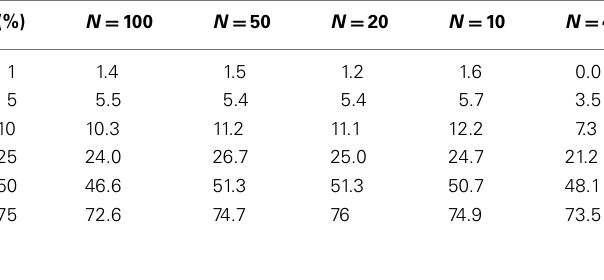
Table 2 | Level accuracy of permutations as a function of decreasing sample size over 1000 simulations for continuous variables.